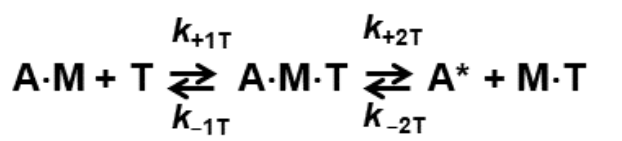
Figure 2. ATP-induced actomyosin dissociation. A = pyrene labeled actin, M = myosin, T = ATP. A* = actin with the high pyrene fluorescence.